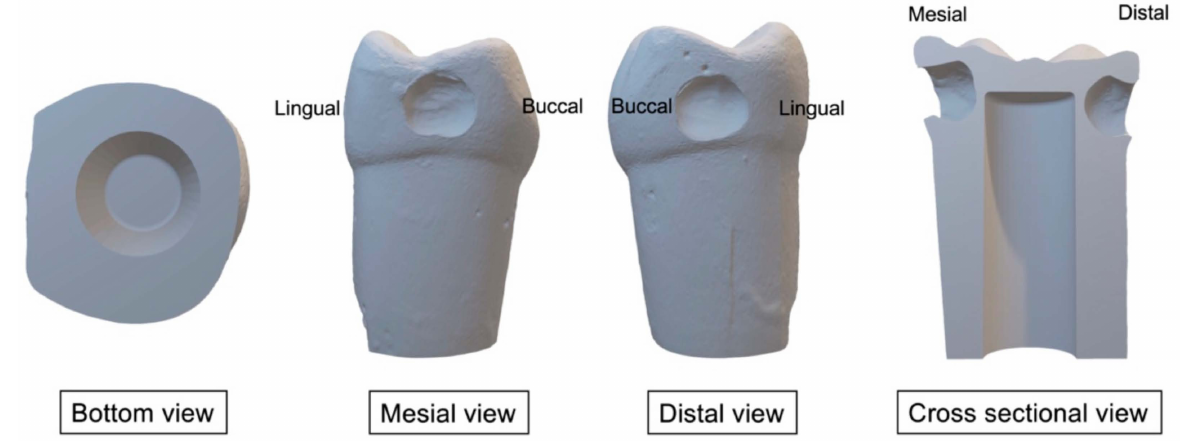
Figure 2. 3D images of the permanent lower-left first molar with the proximal cavity. The printed teeth were filled with dental wax from the bottom to mimic the appearance of dental pulp (Figures 3A and 4A). Then, the caries layer was placed on the deepest part of the occlusal and proximal cavities. The simulated caries layer was prepared with resin- modified glass ionomer cements using a powder-to-liquid ratio of 1:3. We added the color modifier (~1 wt%) to the resin-modified glass ionomer cement (RMGIC) to mimic the brown/yellowish appearance of a caries lesion. The RMGIC was placed in the deepest part of the cavity (thickness ~3 mm) and light-cured using a light-emitting diode (LED) curing unit for 5 s (Figures 3B and 4C,D). For the occlusal cavity, we covered the simulated caries layer with a nanofilled resin composite for 1–2 mm (Figure 3C). For the proximal surface, we left the simulated caries uncovered at the proximal side to produce the shadow appearance on the marginal ridge (Figure